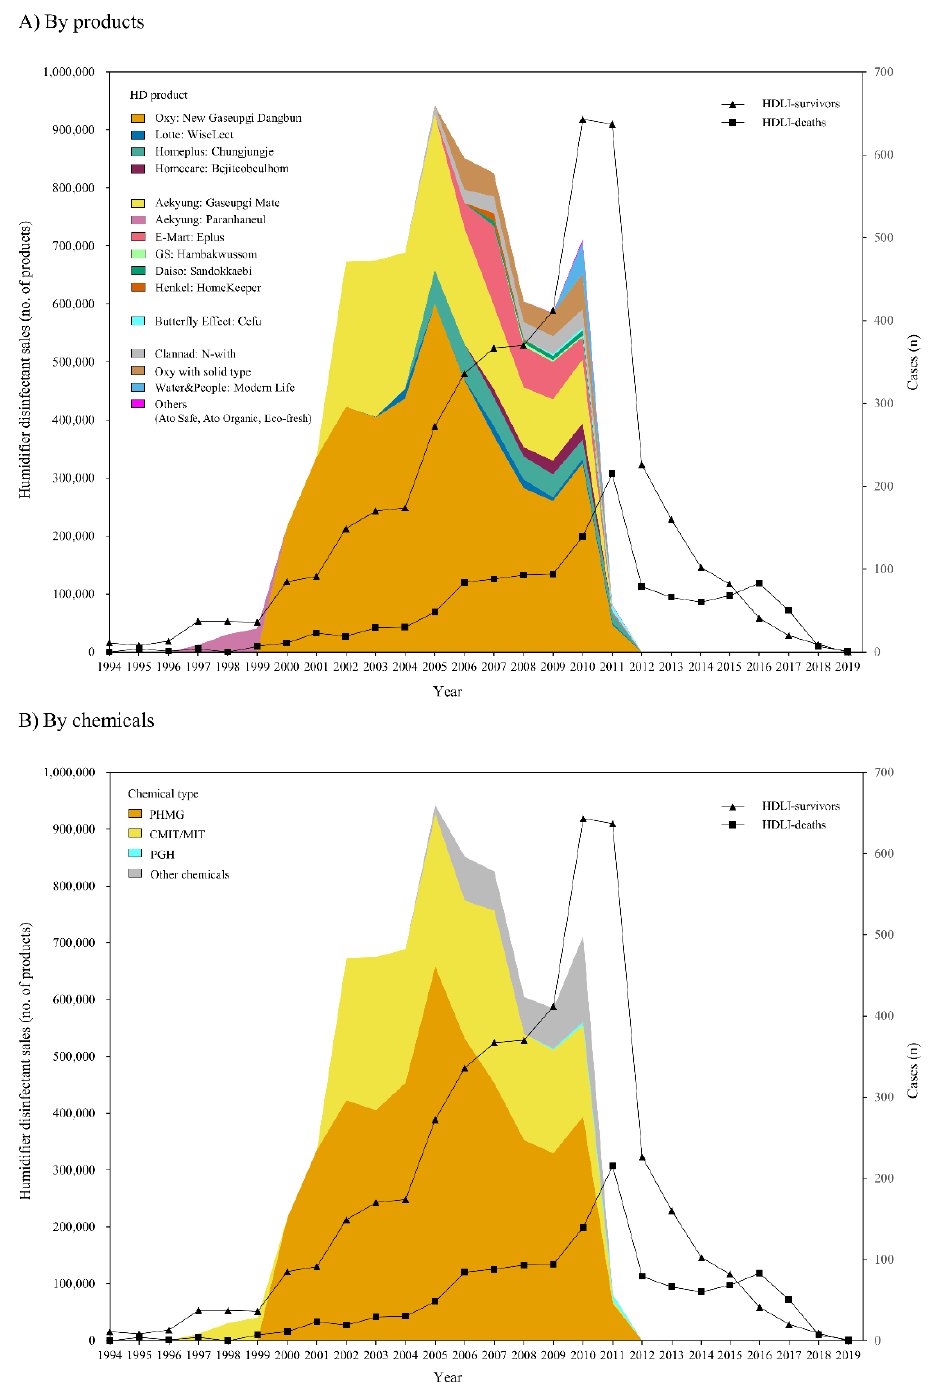
Figure 2. Annual sales of humidifier disinfectants and self-reported cases of HDLI.